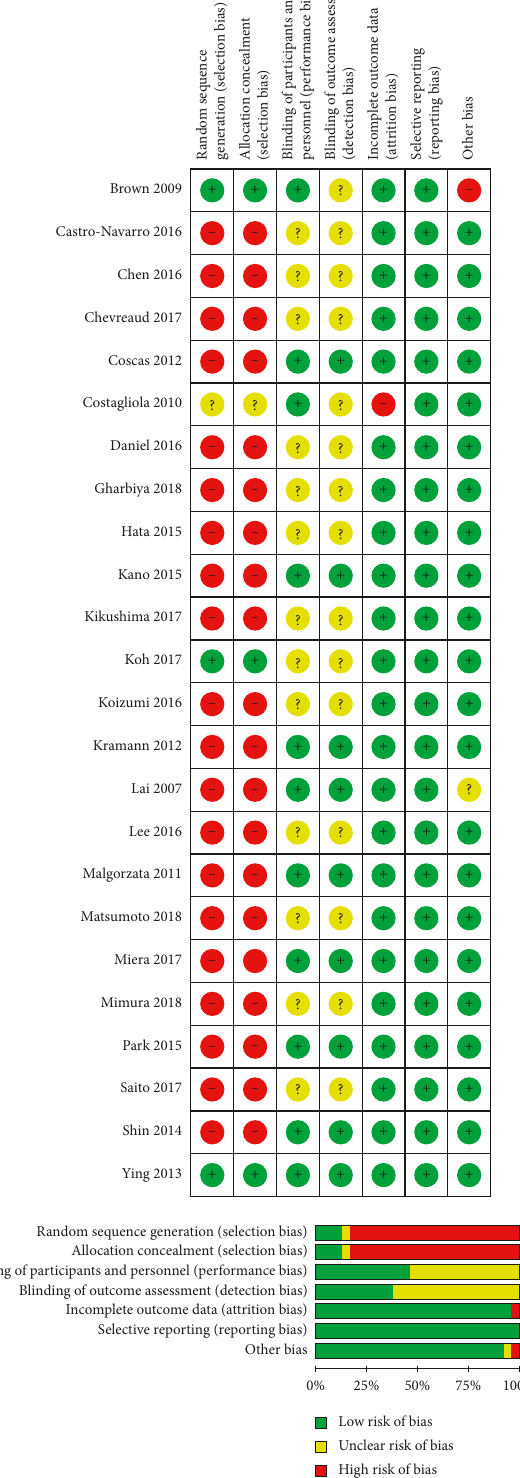
Figure 2: Risk of bias assessment of the included